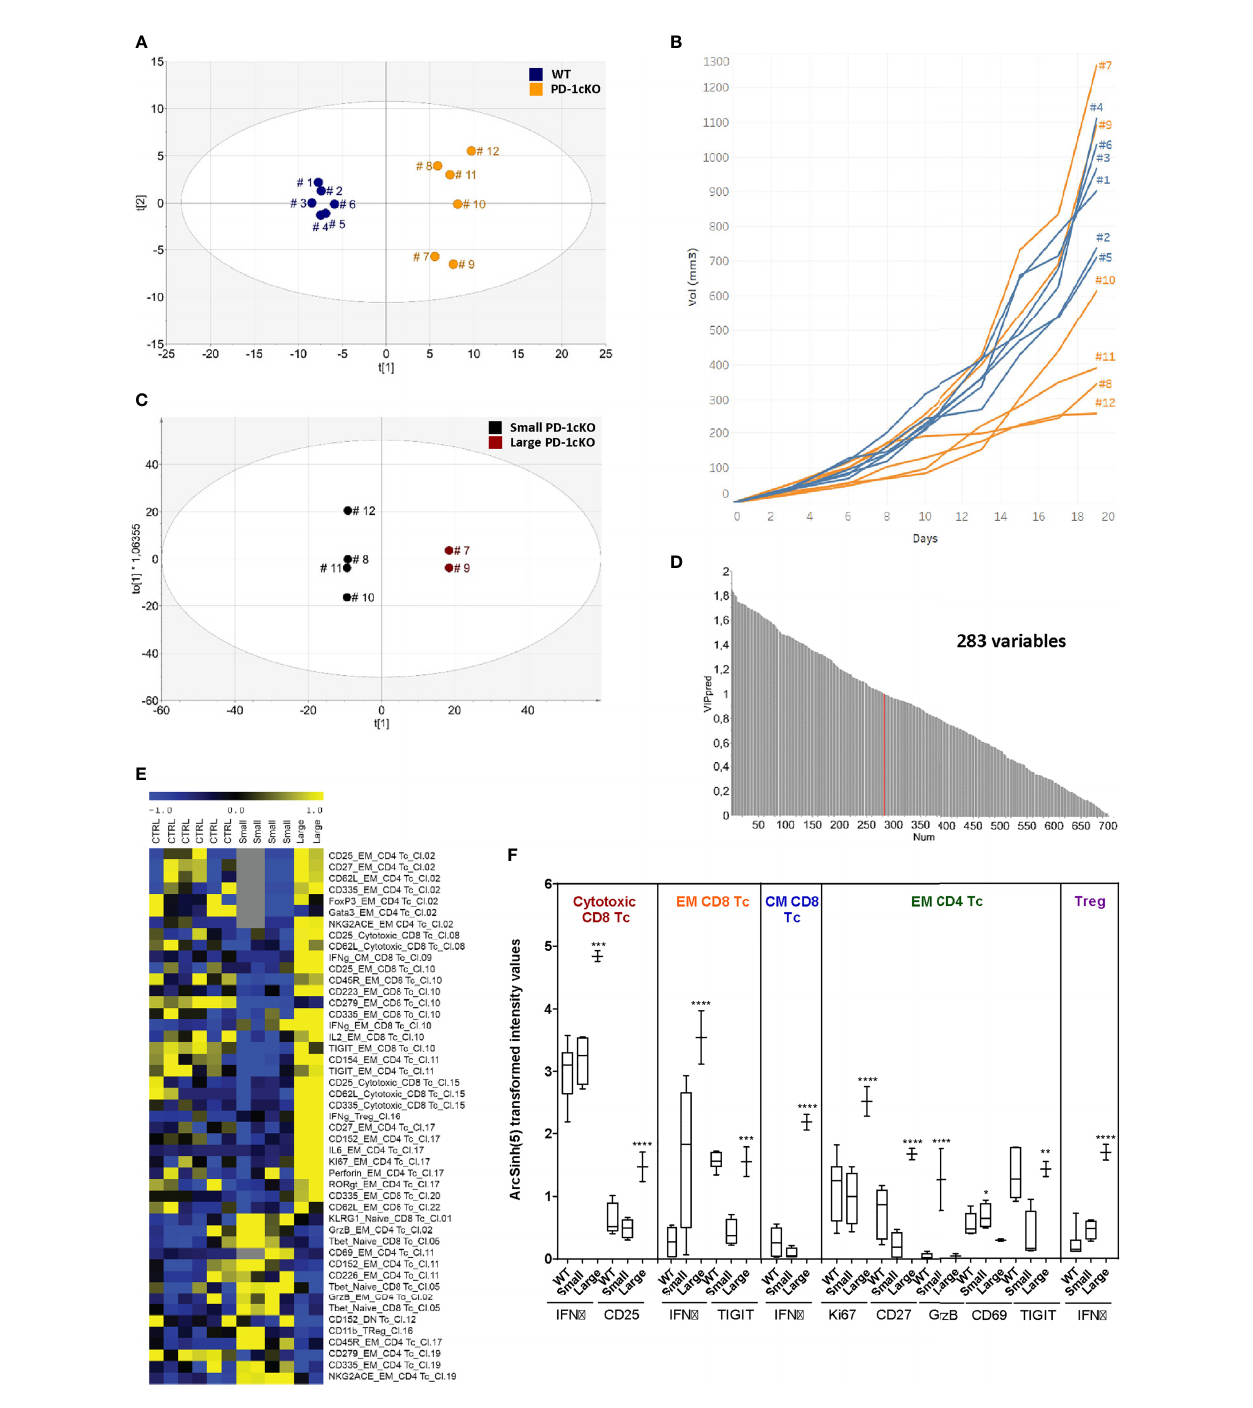
FIGURE 4 | Large and small tumors have a distinct phenotypic signature in the PD-1cKO mice. (A) OPLS discriminant analysis (OPLS-DA) score scatter plot displaying the separation of PD-1cKO and WT mice based on X-variables. (B) MC-38 tumor growth in individual WT or PD-1cKO mice. (C) OPLS-DA score scatter plot displaying the separation of phenotype of tumor-in fi ltrating lymphocytes isolated from small and big tumors in PD-1cKO mice. (D) Statistical analysis selected variables signi fi cantly affected after PD-1 blockade compared to the respective control mice. (E) Heatmap depicting the signature of clusters upregulated in the small versus big tumors in the PD-1cKO mice. Data normalized to the mean and reduced to the SD for each variable. (F) Differential expression of selected markers in WT and small and big tumors in PD-1cKO mice expressed as asinh (5) transformed intensity value. *p < 0.05, **p < 0.01, ***p < 0.001, ****p < 0.0001. Data from one experiment with n = 6 mice/experiment, group, and time